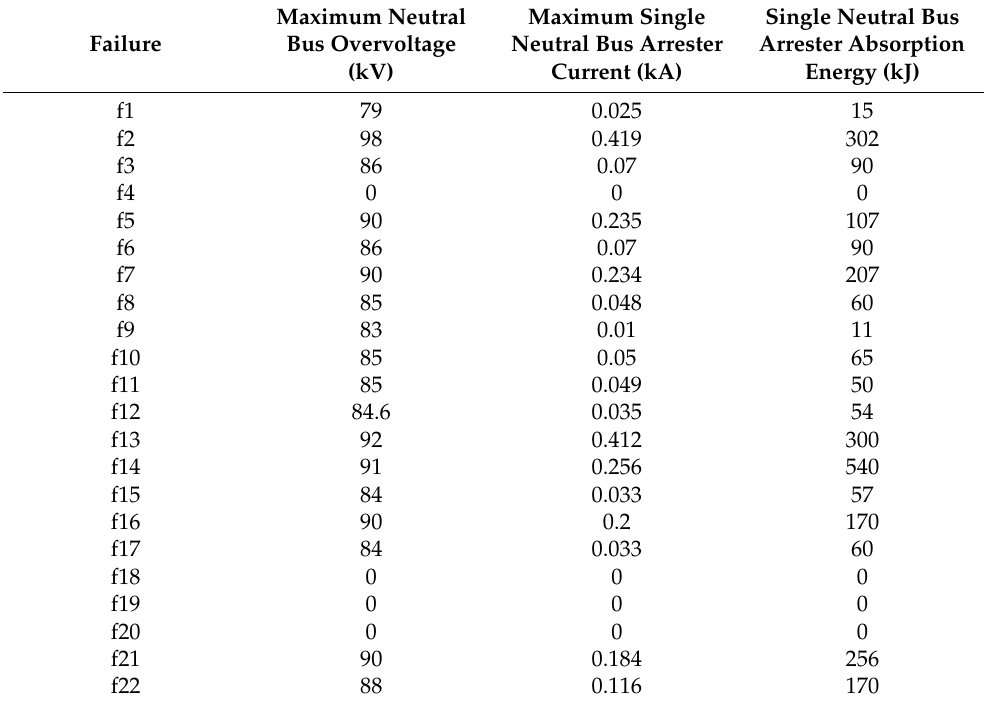
Table 7. Arrester voltage, current, and energy of different fault conditions under the monopole metal loop operation